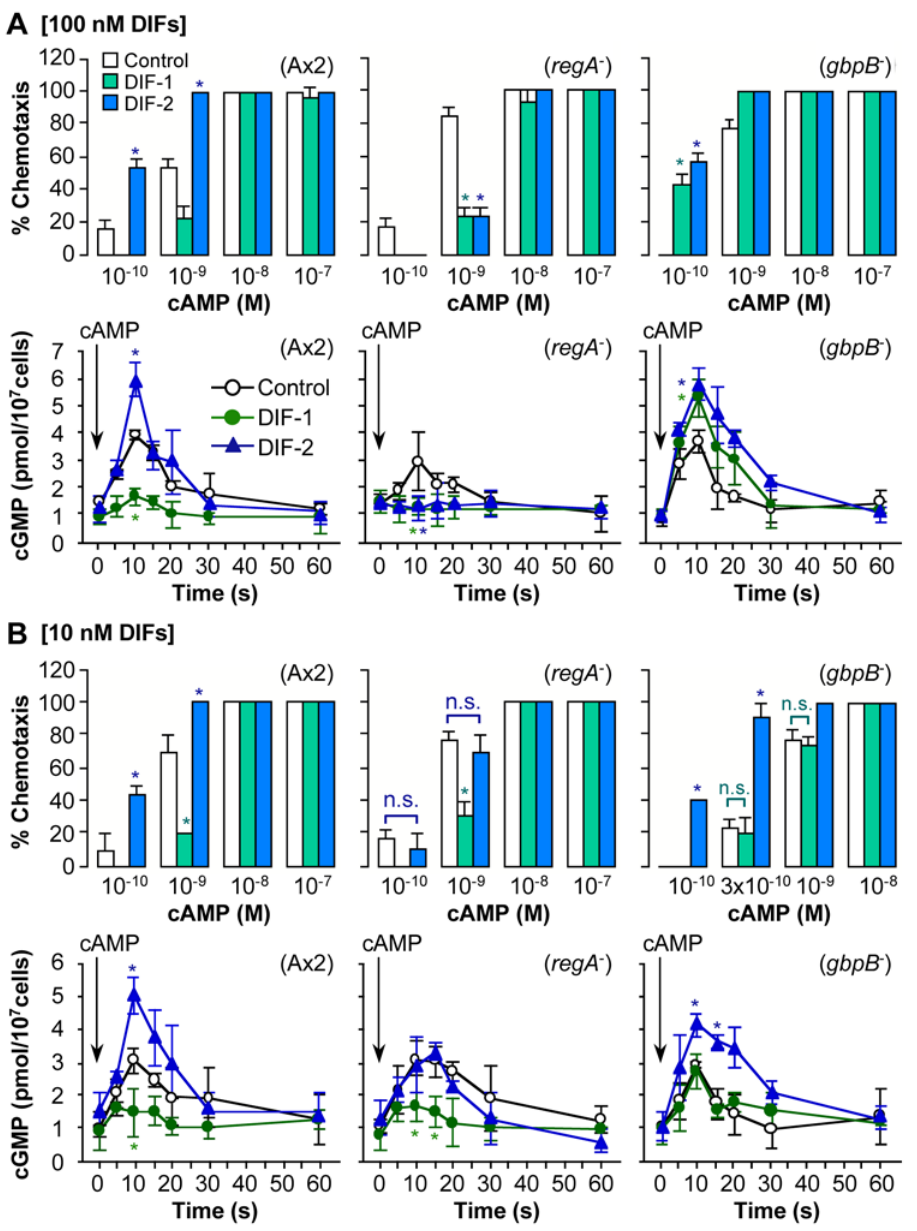
Figure 6. Effects of DIF-1 and DIF-2 on chemotaxis and intracellular cGMP in Ax2, regA - , and gbpB - cells. (A, B) Cells starved for 6 h were spotted on PB agar containing 3 mM caffeine (Control) plus 100 nM (A) or 10 nM (B) of DIF-1 or DIF-2 and assayed for chemotaxis toward the indicated doses of cAMP ( top ). Starved cells in shake-culture were stimulated with 0.3 nM cAMP (final concentration) in the presence of 3 mM caffeine (Control) plus 100 nM (A) or 10 nM (B) of DIF-1 or DIF-2, and aliquots of the cells were collected for assay of cGMP contents ( bottom ). Data are the mean and s.d. (bars) of three independent experiments (n=3). * P , 0.05, as compared with Control.